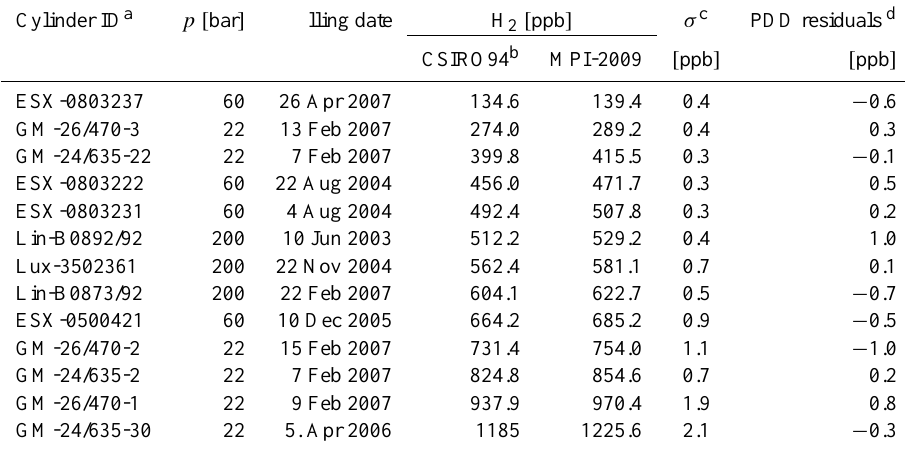
Table 1. Set of reference